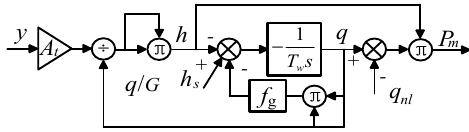
Figure 7. Pump mode model under small guide vane opening.